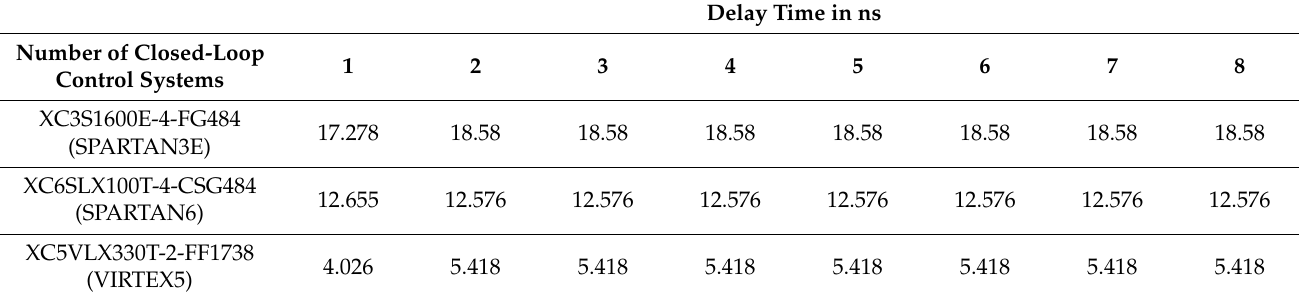
Table 4. Delay time analysis of FPGA logic for different numbers of closed-loop control systems with different